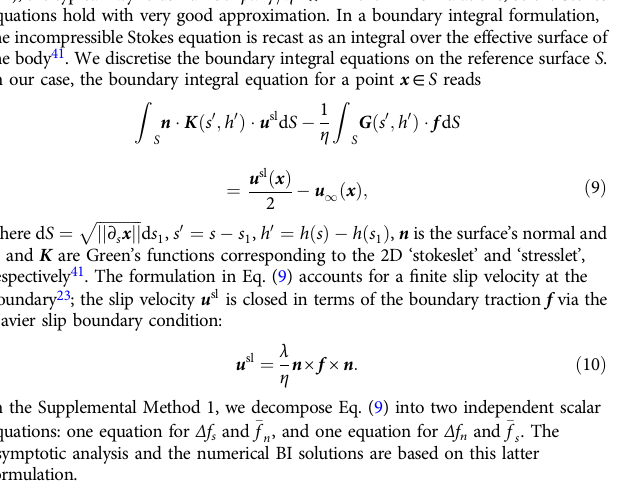
GO stands for graphene-oxide and the percentage is the ratio between oxygen and carbon